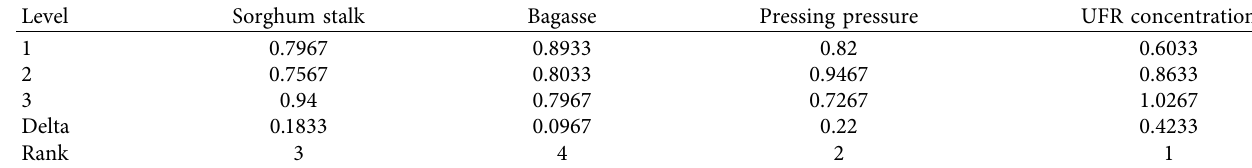
Table 4: Response for signal-to-noise ratios “larger is better” for IB.